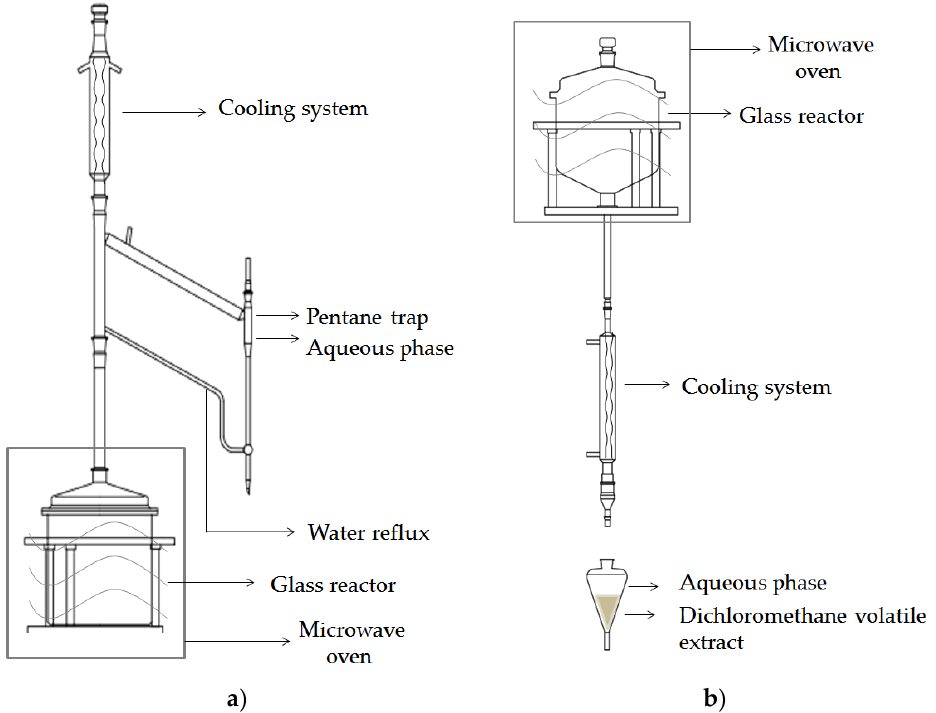
Figure 1. Scheme of the apparatus for microwave-assisted isolation. ( a ) Microwave-assisted distillation (MAD); ( b ) microwave hydrodiffusion and gravity (MHG).